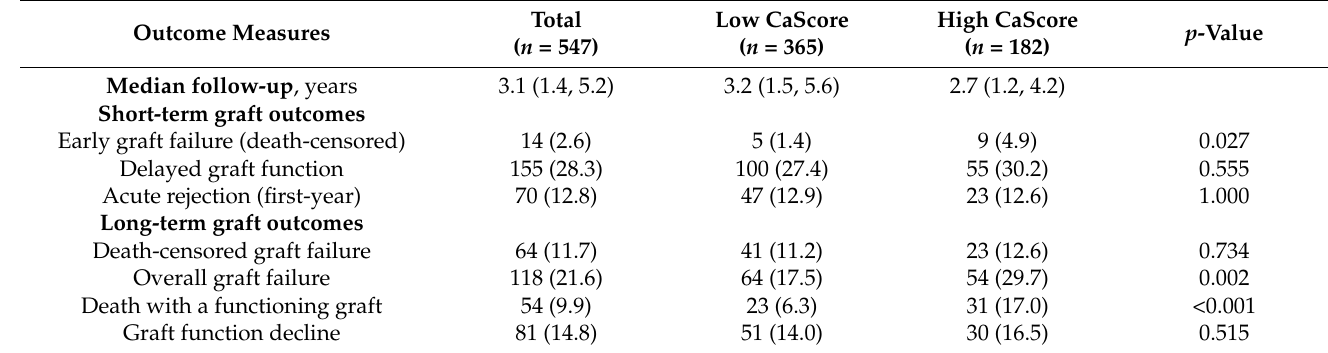
Table 2. Short and long-term graft outcomes (numbers,